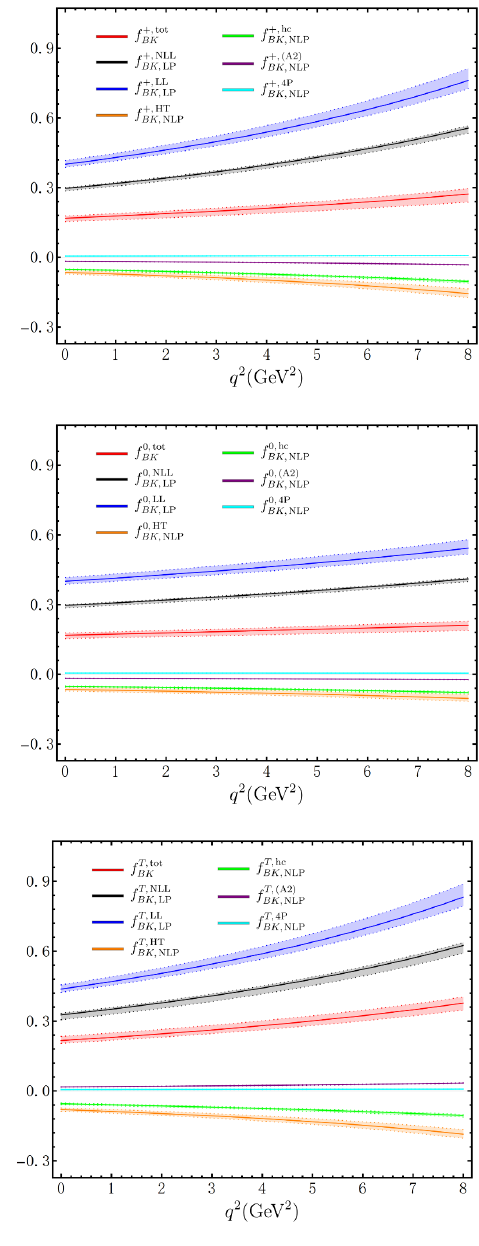
Figure 3 . Breakdown of the distinct dynamical mechanisms contributing to the semileptonic B → π‘ ¯ ν ‘ form factors (left panel) and to the electroweak penguin B → Kν ‘ ¯ ν ‘ decay form factors (right panel) in the kinematic region 0 ≤ q 2 ≤ 8 GeV 2 from the updated LCSR computations with the HQET bottom-meson distribution amplitudes, where the perturbative uncertainties due to the variations of both the hard and hard-collinear matching scales are indicated by the individual error